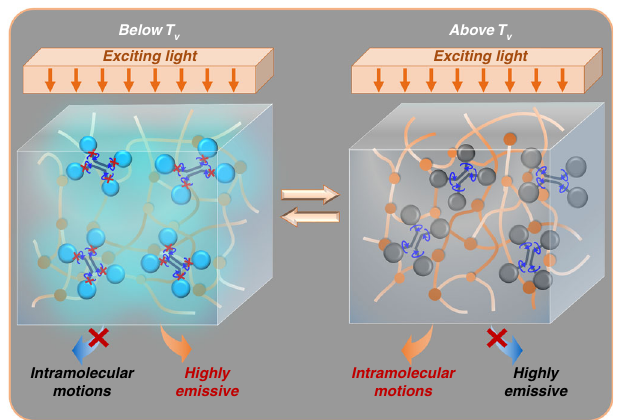
Fig. 1 AIE-doped vitrimer is highly emissive below T v and weakly emissive above T v . Below T v , AIE molecule is restricted to intramolecular